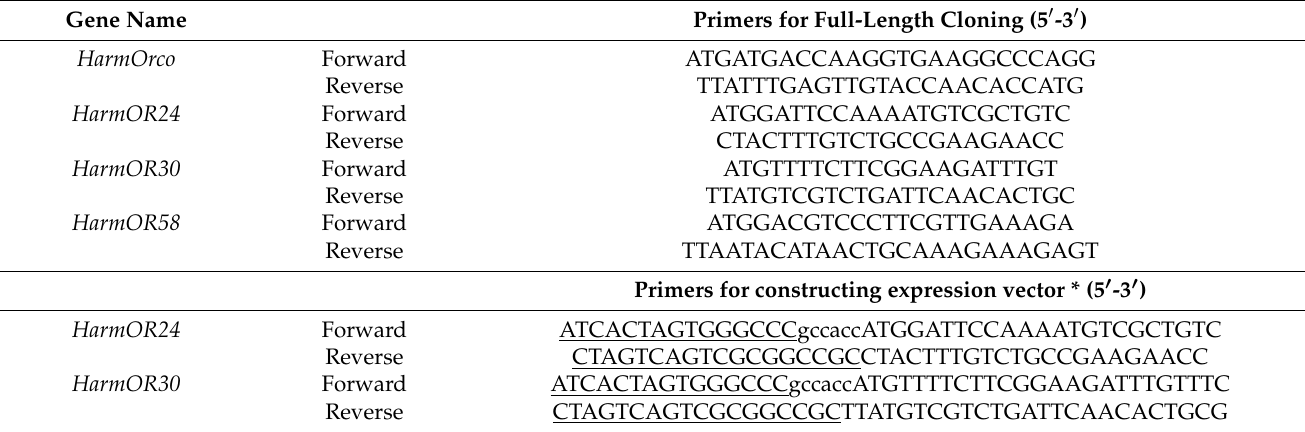
Table 1. Primers for full-length cloning and expression vector